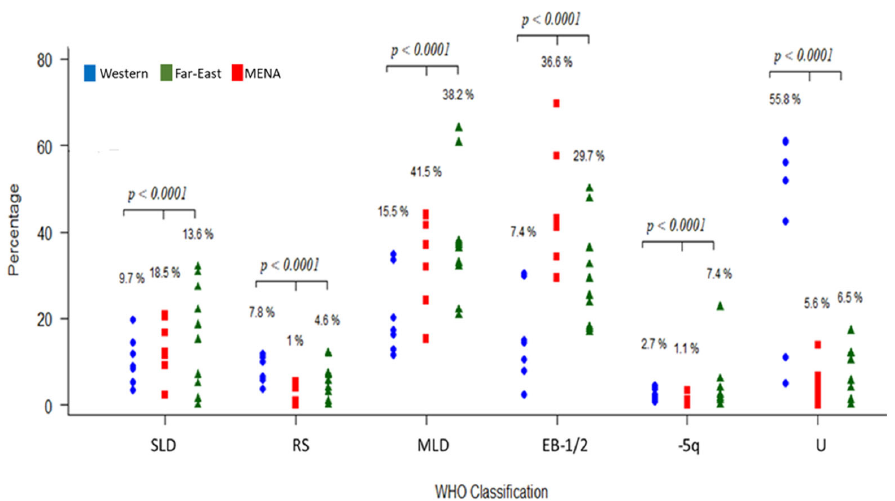
Figure 5. Comparison of the distribution of MDS subtypes between Western, Far East, and MENA populations. Western and Far East data were taken from [30–41]. MDS = myelodysplastic syndrome, MLD = multilineage dysplasia, SLD = single-lineage dysplasia, RS = ring sideroblasts, EB = excess blasts, − l5q = isolated del(5q), U = unclassi fi able.